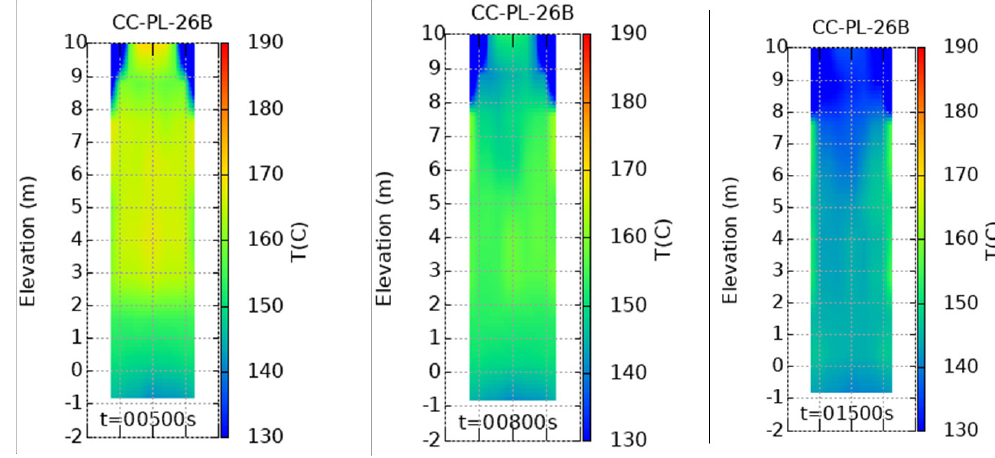
Figure 14. Comparison of the temperature contour on the cross-section as ( a ) measured and ( b ) numerically predicted by means of the SST k-ω turbulence model with CHT before water injection in the upper pool and middle jacket.